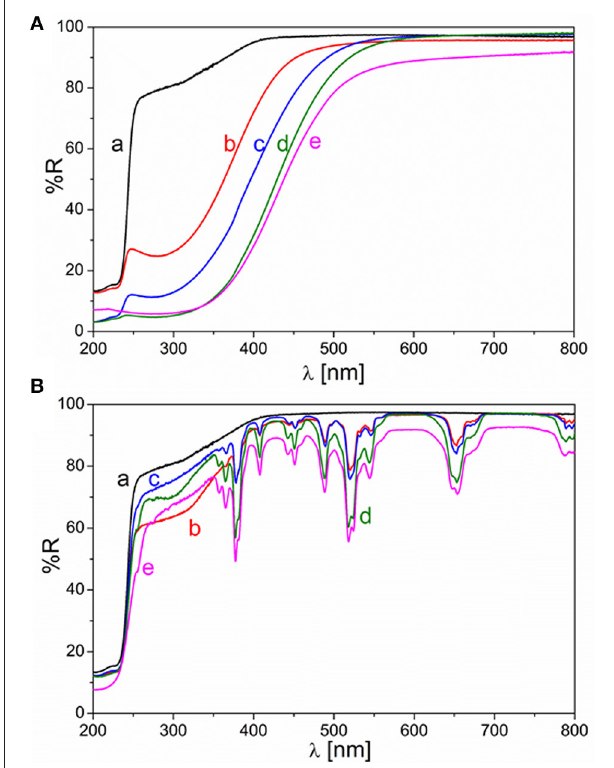
FIGURE 8 | Diffuse reflectance absorbance spectra of pure ZrO 2 (a, black) and RE-doped ZrO 2 [ (A) RE = Ce, (B) RE = Er] with increasing concentration of RE dopant: 0.5mol % (b, red), 1mol % (c, blue), 5mol % (d, green), and 10mol % (e,